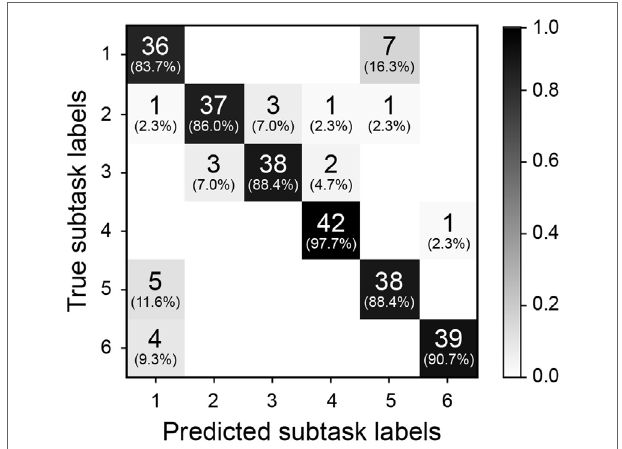
FigUre 10 | The confusion matrix is shown for 100% of the elapsed time of a novel gaze object sequence for each subtask. Predicted subtask labels (columns) are compared to the true subtask labels (rows). Each subtask has a total of 43 relevant sequences and (43*5) irrelevant sequences. Each shaded box lists the number of label instances and parenthetically lists the percentage of those instances out of 43 relevant